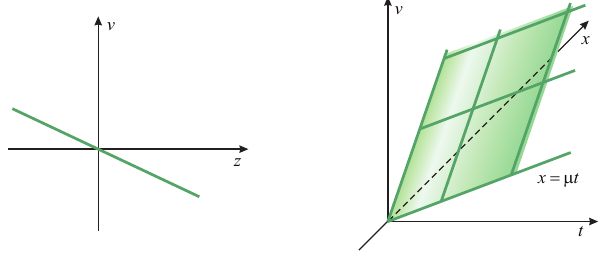
Figure 4. Solution v ( z ) = − γ z and diffusion wave u = − σµ ( x − µ t ) .